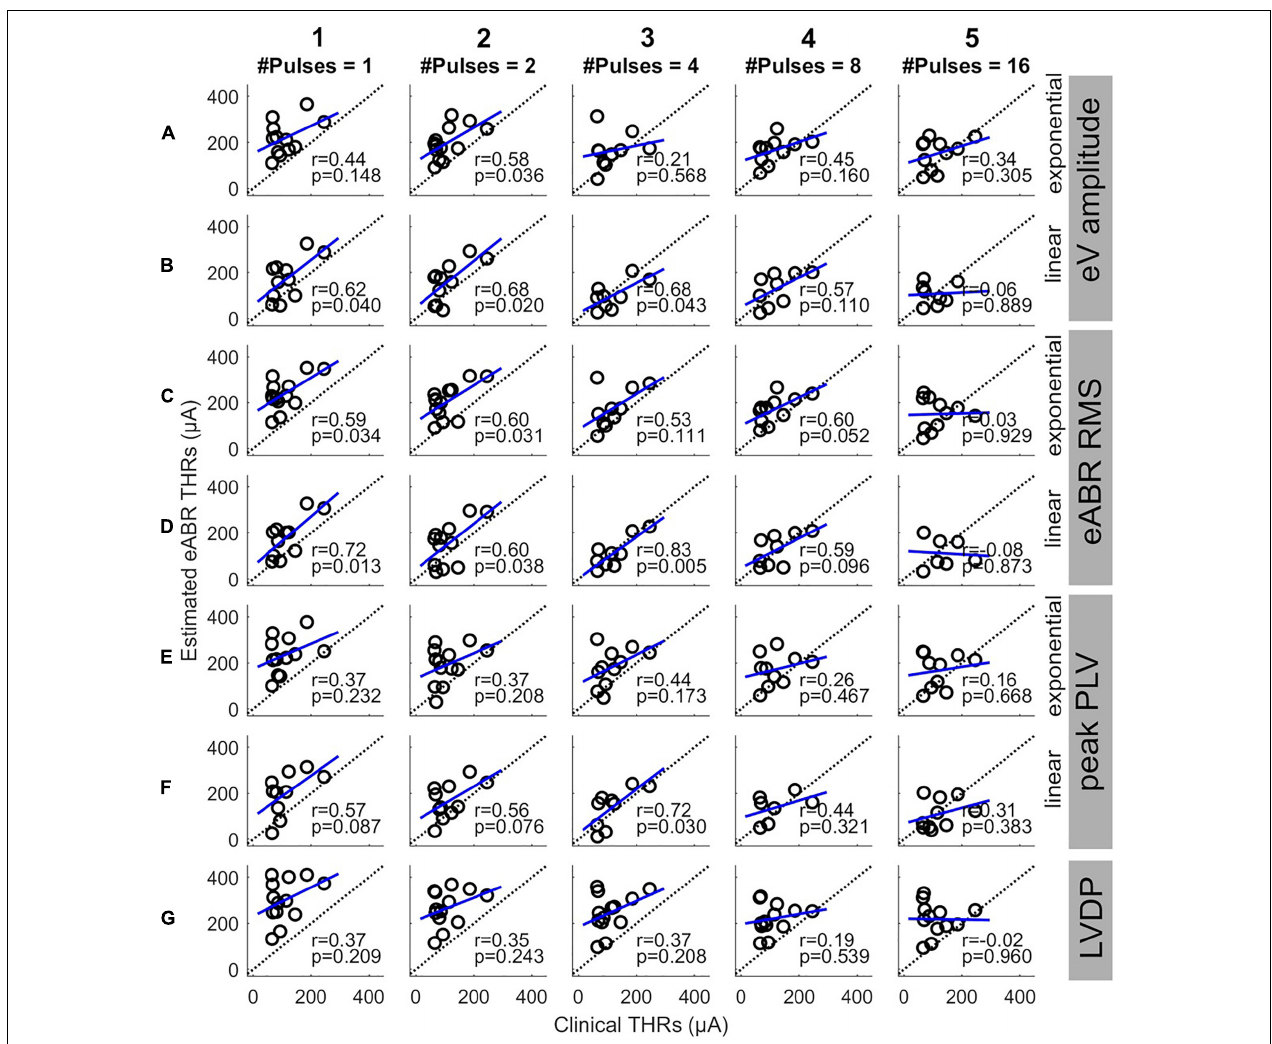
FIGURE 8 | Estimated eABR THRs as a function of clinical THRs for multi-pulse conditions. Each column shows results of a specific number of pulses. Panels (A,B) show the eABR THRs estimated from AGFs of wave eV with exponential and linear fittings, respectively. Panels (C,D) present the eABR THRs estimated from growth functions of eABR RMS values with exponential and linear fittings, respectively. Panels (E,F) present the eABR THRs estimated from growth functions of peak PLV with exponential and linear fittings, respectively. Panels (G) show the eABR THRs resulted from the LVDP method. Open circles present data from individual subjects. Dotted black lines show the identity lines and the blue lines show linear regressions. In each panel, the correlation coefficient ( r ) and the probability value ( p ) are